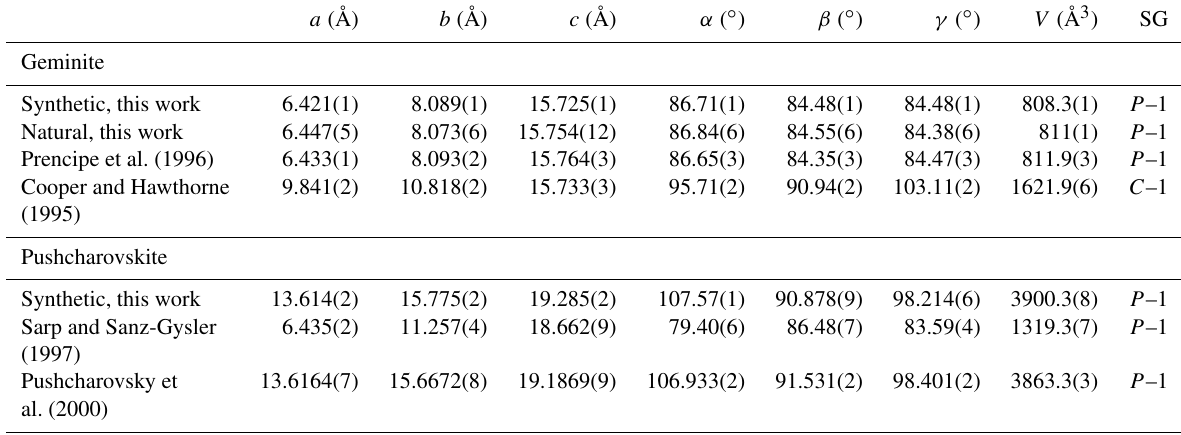
Table 1. Unit cell parameters for geminite and pushcharovskite from this work, compared to values from studies on natural